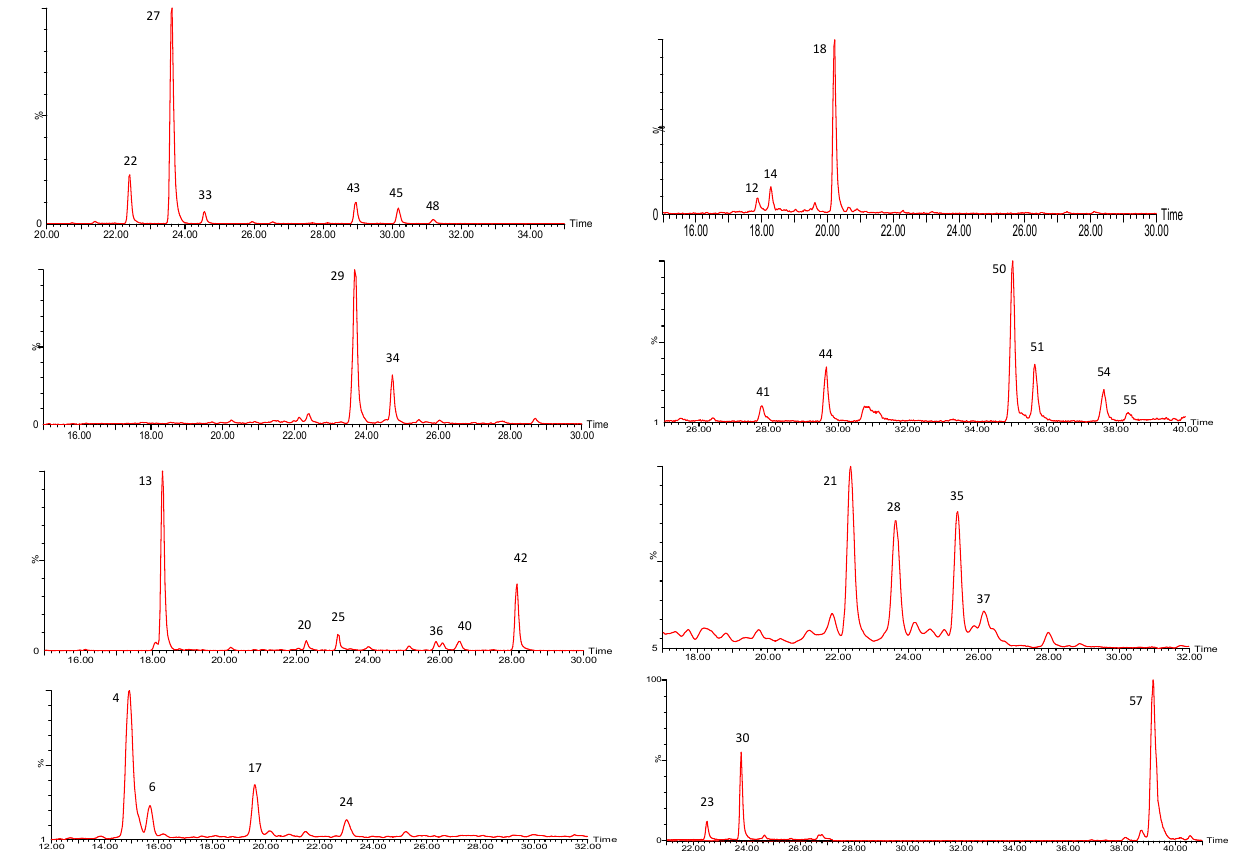
Figure 1. UPLC QTOF-ESI MS extracted ion chromatograms of withanolides from P. peruviana husks and fruits.